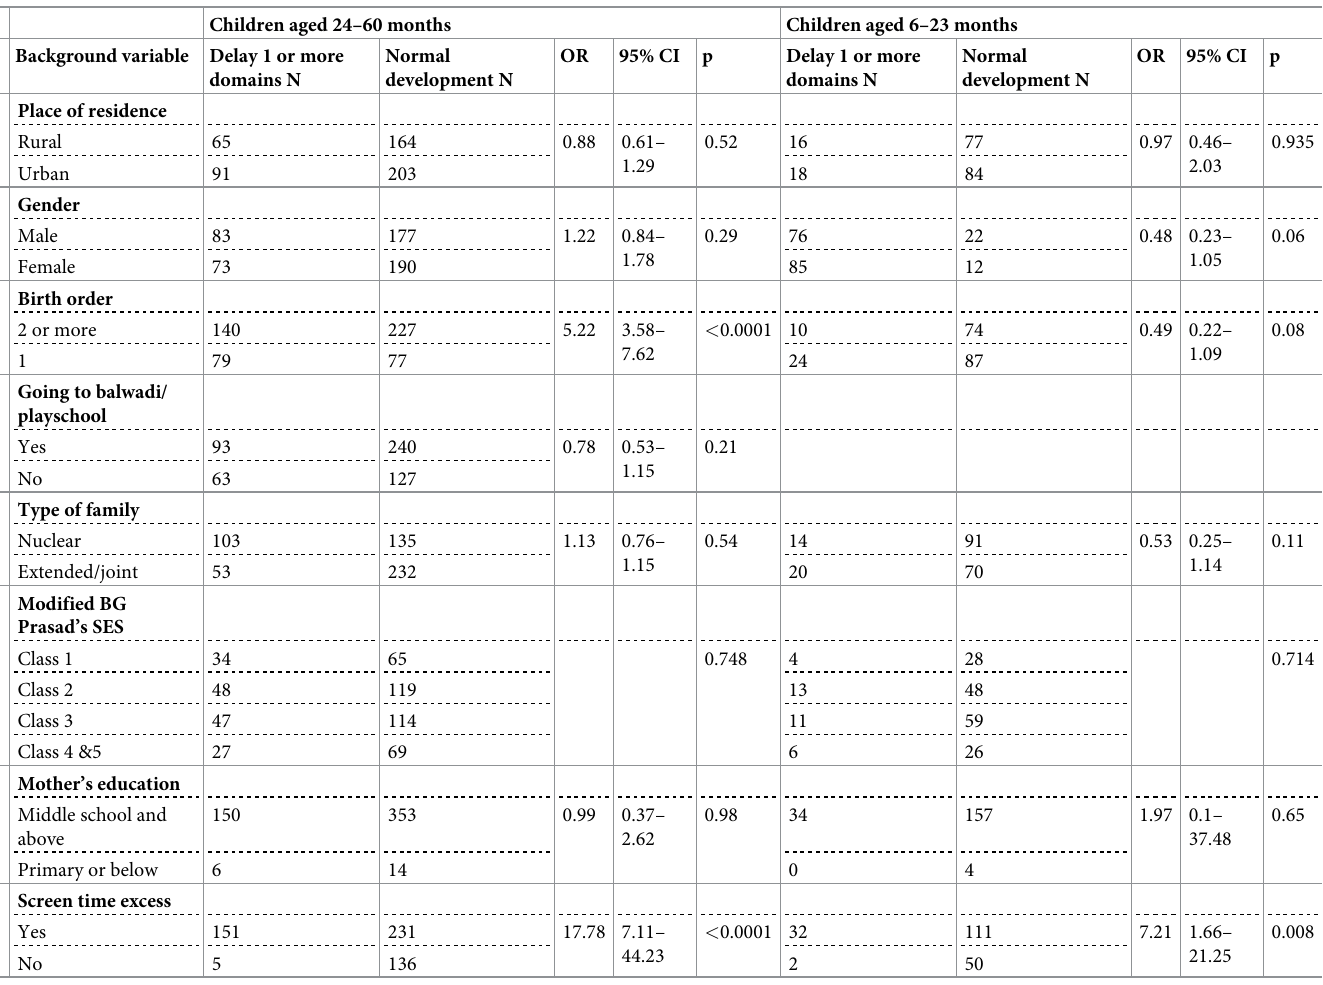
Table 4. Developmental delay domains and their associated